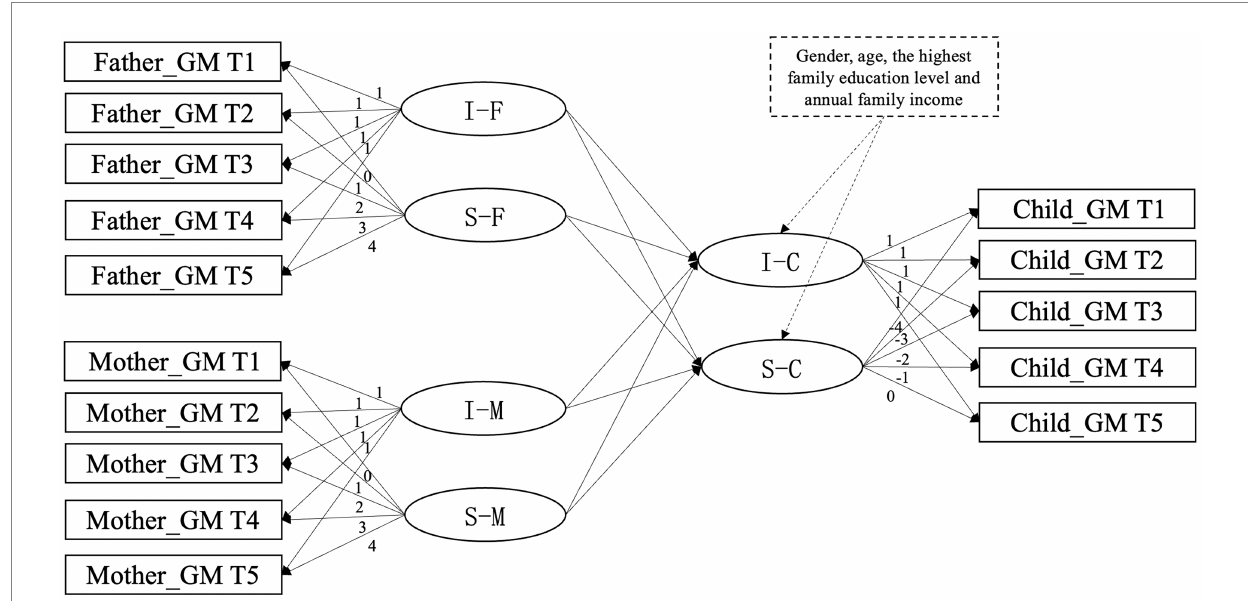
FIGURE 1 Parallel process latent growth curve model of children’s and father’s and mother’s growth mindset. For clarity reasons, intercept and slope factor loadings for variable and correlation coefficients are not depicted. GM, growth mindset; S,